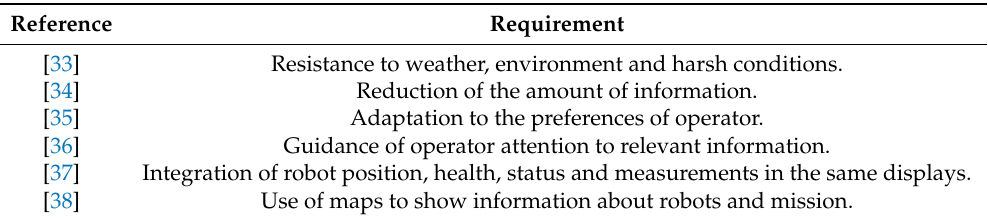
Table 3. The requirements for interfaces collected by